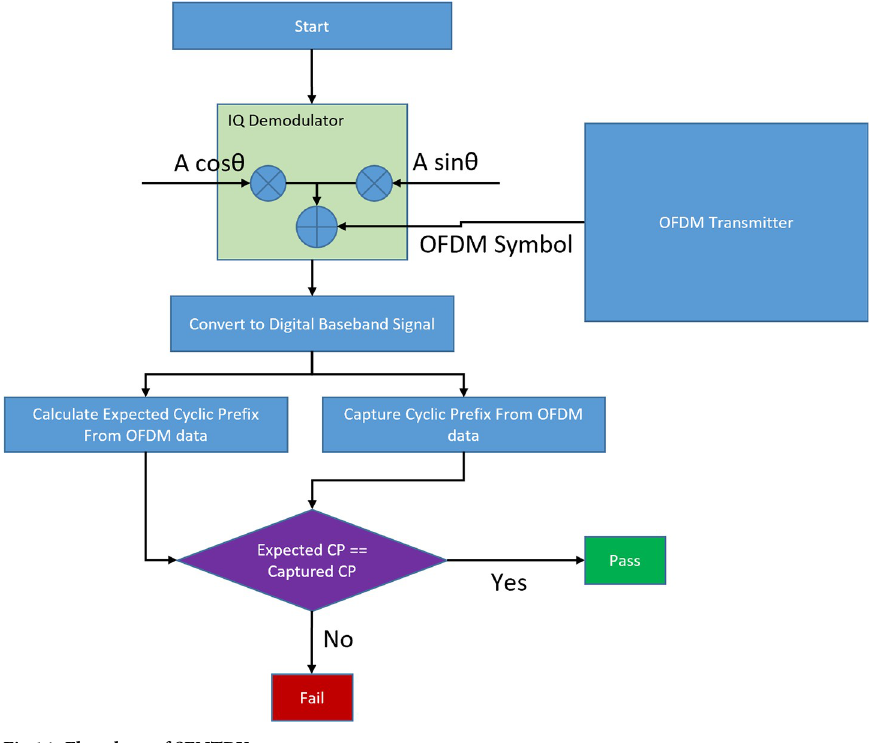
Fig 14. Flowchart of